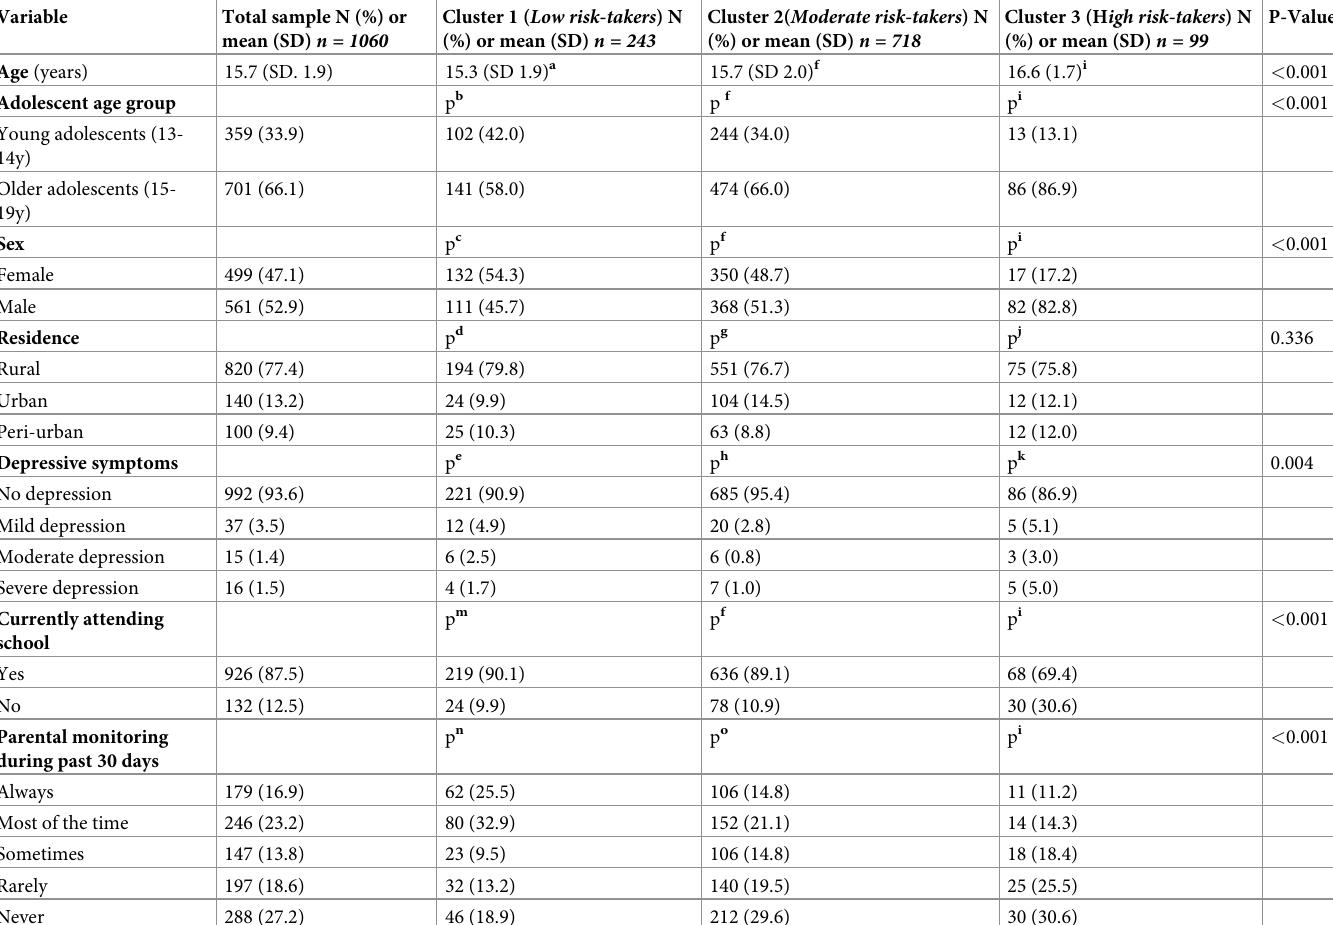
Table 3. Socio-demographic and psychosocial characteristics of the 3 behavioral